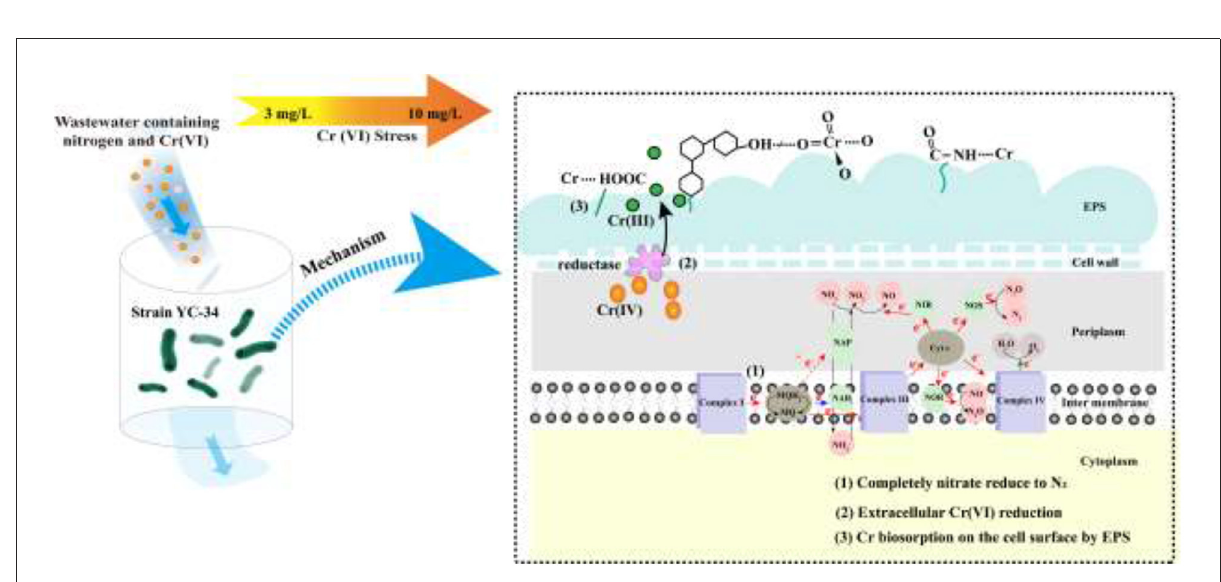
FIGURE8 The speculative nitrate conversion and Cr(VI) removal mechanism of strain